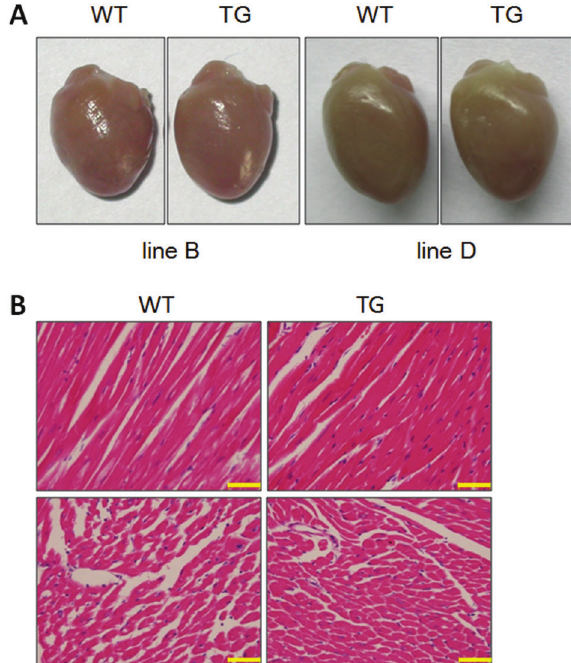
Figure 1. Generation of cardiac-speci fi c transgenic (TG) mice overexpressing MyD88. A , Construction map of MyD88 TG mice. MHC: myosin heavy chain; MyD88: myeloid differentiation factor 88; hGH-pA: human growth hormone poly A signal; WT: wild-type. B , PCR of genomic DNA from mouse tails was performed for genotyping. A 711-bp fragment from the genomic MyD88 allele and a 308-bp fragment from the transgenic Flag-MyD88 allele was PCR- ampli fi ed with the genotyping primers. C , Tissue-speci fi c expression of the transgene in MyD88 TG mice was performed with anti-Flag antibody. H: heart; SM: skeletal muscle; Li: liver; Sp: spleen; Lu: lungs; Ki: kidney; Br: brain. heart of lines B and D (Figure 1C). Weak MyD88 trans-